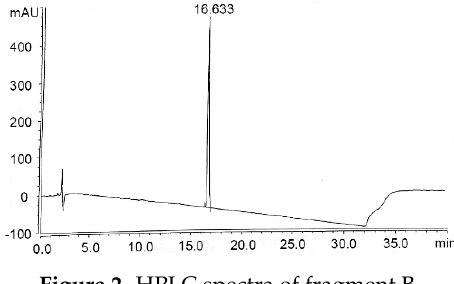
Table 1. Synthesis of protected peptides via BSA/NHS method.